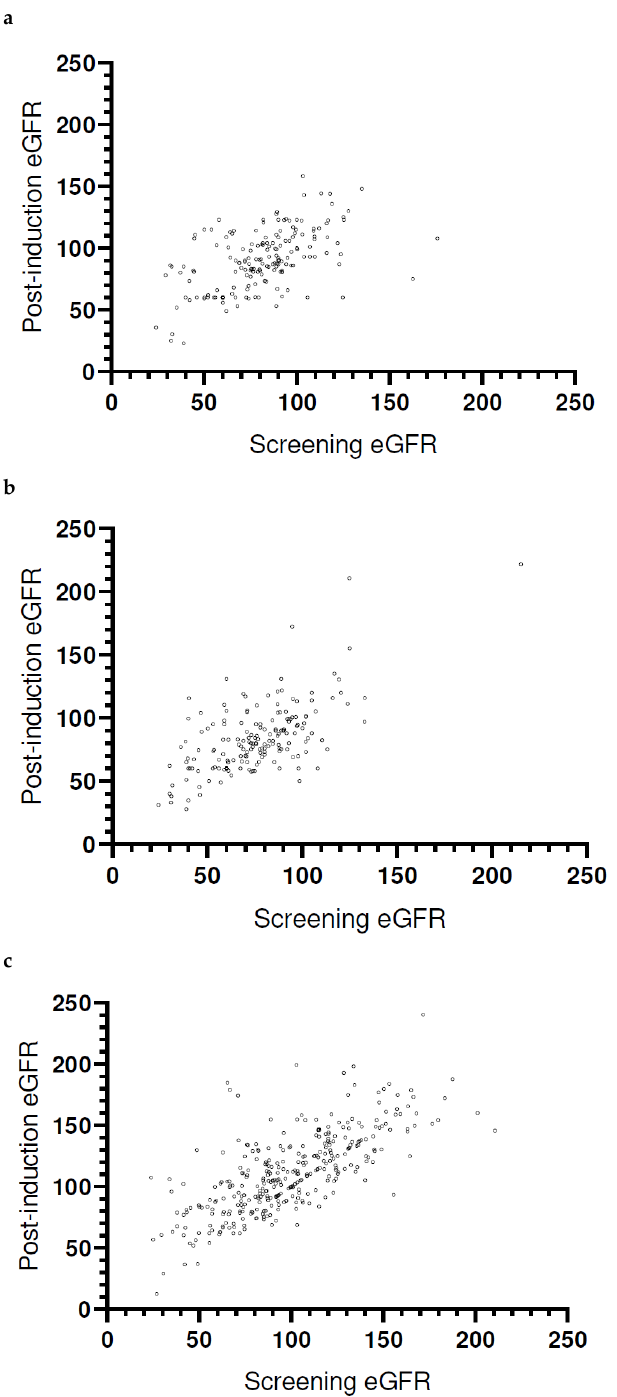
Figure 1. Changes in screening and postinduction GFR categories per induction regimen. ( a ) Two hundred and two patients receiving RAD for induction; postinduction data (not applicable) n.a. for 8 patients (pts). ( b ) Two hundred and fourteen patients receiving VRd for induction; baseline data n.a. in 3, and postinduction n.a. in 17 pts. ( c ) Three hundred and fifty-six patients receiving VCD for induction; baseline data n.a. in 8, and postinduction n.a. in 11 pts. Abbreviations: eGFR, estimated glomerular filtration rate; RAD, lenalidomide, adriamycin, and dexamethasone. VRd, bortezomib, lenalidomide, and dexamethasone. VCD, bortezomib, cyclophosphamide, and